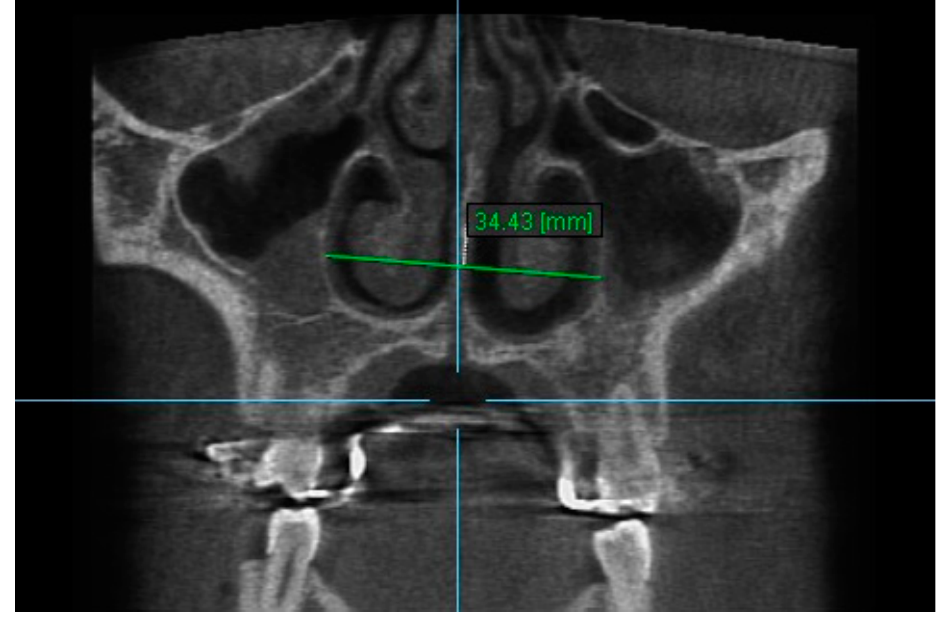
Figure 4. Nasal Width 2. through the center of the mesial buccal root of the first premolar (Figure